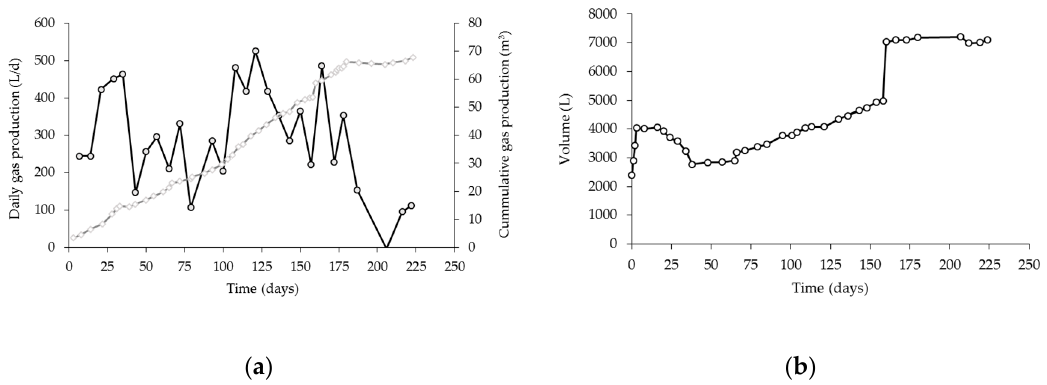
Figure 10. ( a ) Daily gas production and the cumulative gas curve obtained from the start ‐ up of the prototype operating at variable volume; ( b ) Volume profile obtained under the fed ‐ batch strategy.